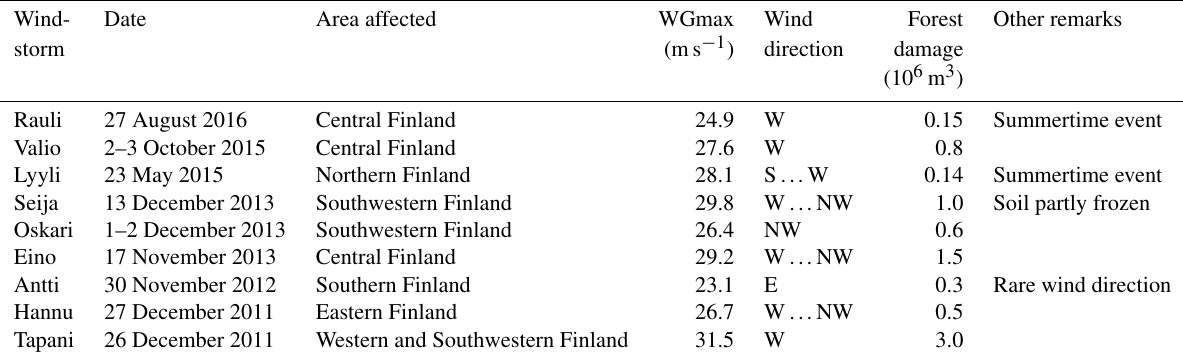
Table 1. The most notable large-scale windstorms in Finland during the 2010s with their maximum observed wind gust speed at inland stations (excluding fell stations) operated by the FMI. The column for wind direction describes the directions of strongest winds associated with the